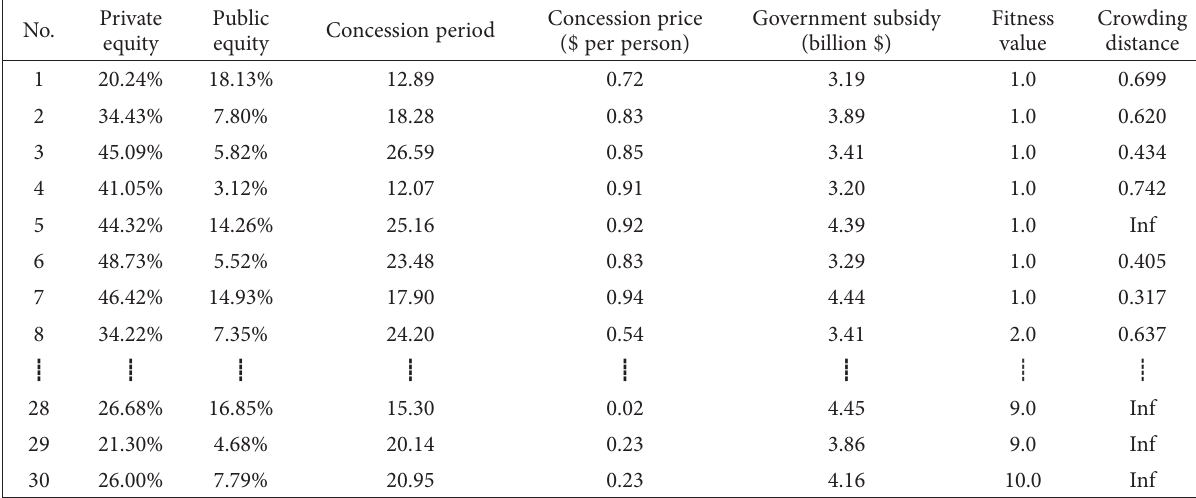
Table 4. Rank of initial population based on non-dominated sorting and crowding distance No.